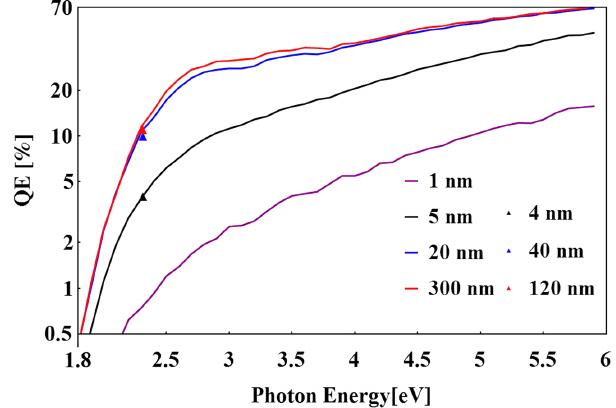
FIG. 13. QE changes with different thicknesses. The dots are the experimental results of the QE of different thickness that matched the simulation very